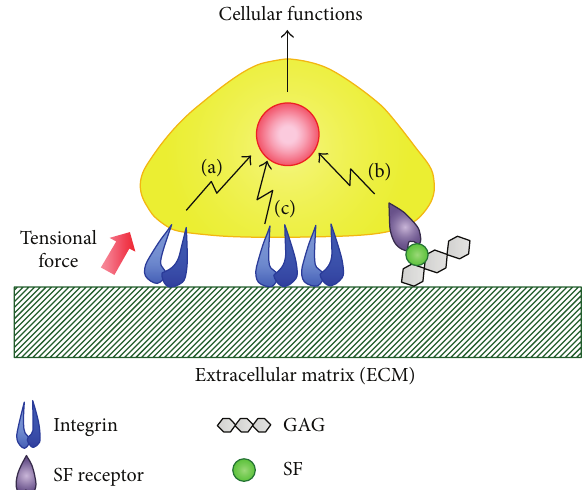
Figure 1: Three regulatory modes of cellular functions. (a) The mechanical stimulation from substrates of different stiffness. (b) Signal activation from soluble factors bound to ECM. (c) Signal activation from adhesion molecules such as integrins. SF indicates soluble factor and GAG indicates